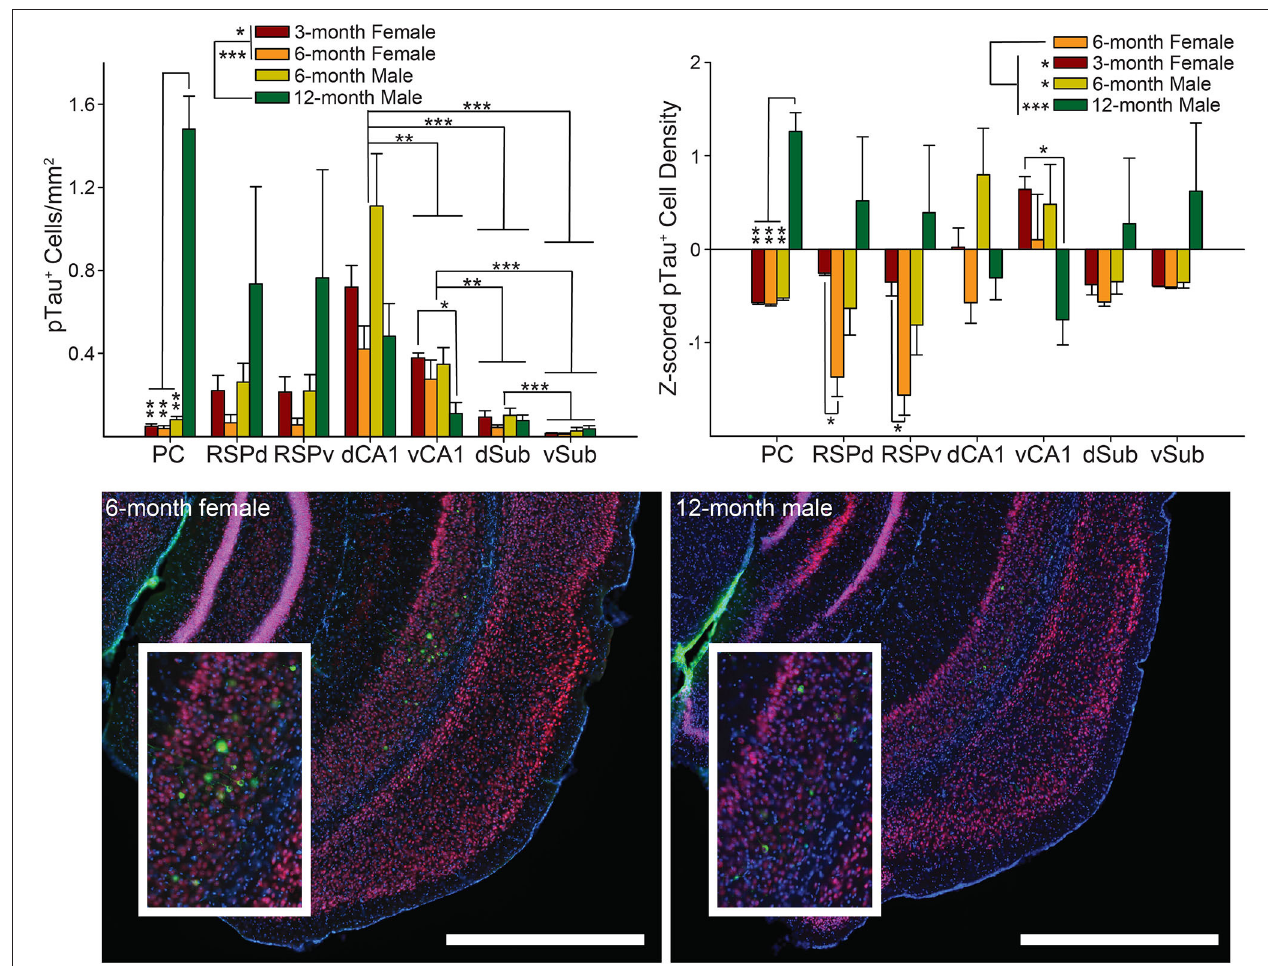
FIGURE 4 | Male 6-month 3xTg-AD mice have the highest density of intracellular tau positive cell density. Top . Tau positive cell density ( left ) and Z -scored density ( right ) for each of the seven brain regions and four groups of mice. Bottom . Representative images showing pTau staining (green) in vSub (Insets) for 6-month female ( left ) and 12-month male ( right ) 3xTg-AD mice. Interestingly, despite the low density of pTau positive cells, staining in 6-month female mice was much brighter in vSub than any other brain region; however, staining was not bright in 12-month males. Sections were also stained with NeuN (red) and DAPI (blue). Dorsal CA1 (dCA1), Ventral CA1 (vCA1), Dorsal Subiculum (dSub), Ventral Subiculum (vSub), Dorsal Retrosplenial Cortex (RSPd), Ventral Retrosplenial Cortex (RSPv), and Parietal Cortex (PC). * p < 0.05, ** p < 0.01, *** p < 0.001. Scale bar =